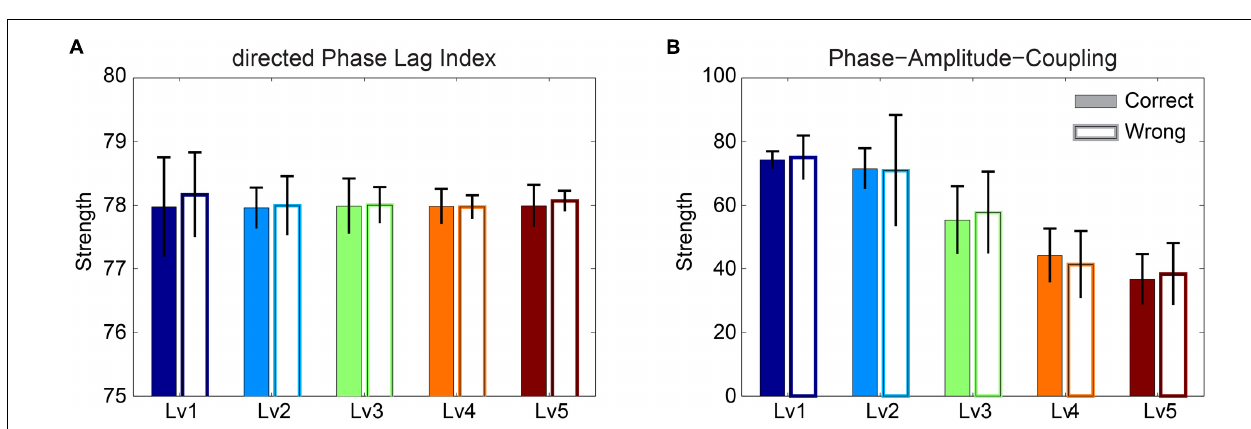
FIGURE 5 | Strength of (A) dPLI and (B) PAC between Frontal θ and Parieto-Occipital α 2 (F 2 × θ – PO α 2 ) for both correct and wrong answers. Bars represent mean ± standard deviations. No statistical significant differences were detected between correct and wrong